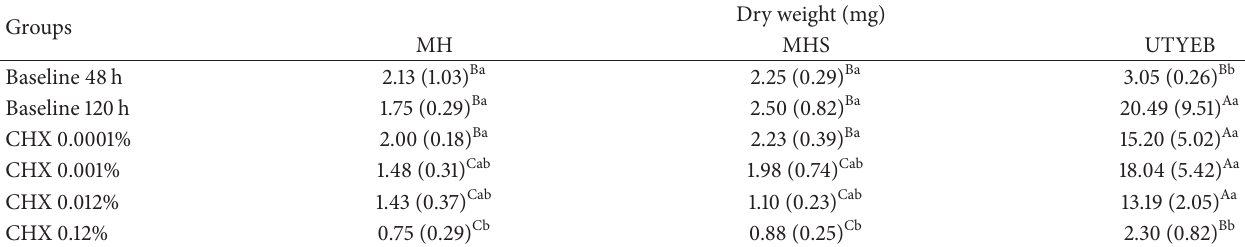
Table 1: % means and standard deviations of dry weight in the biofilms growth according to the treatments. Groups